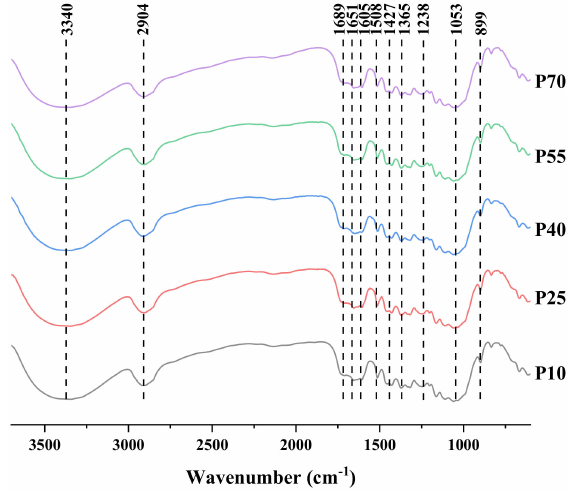
Figure 6. Infrared spectra of corn stalk treated with different ultrasonic power.